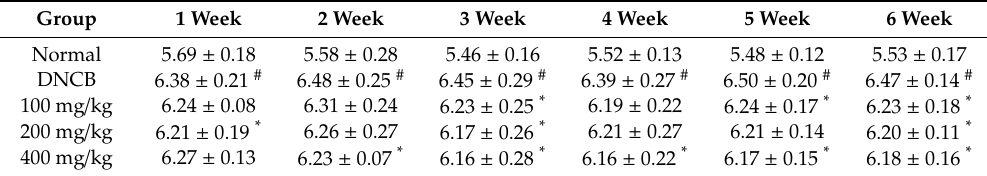
Table 1. The e ff ect of CQ on the skin pH in DNCB-induced BALB / c mice.